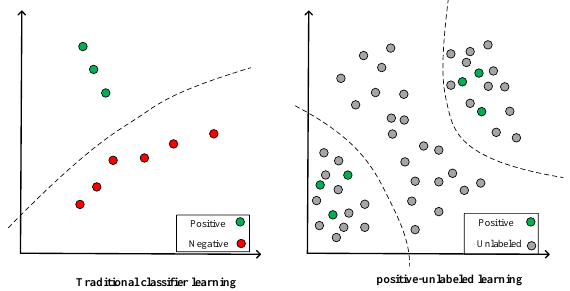
Figure 1. Traditional classifier learning and positive-unlabeled learning.